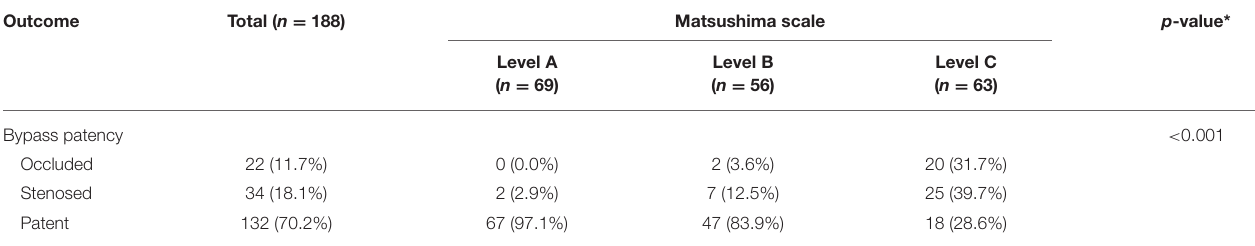
TABLE 2 | Angiographic